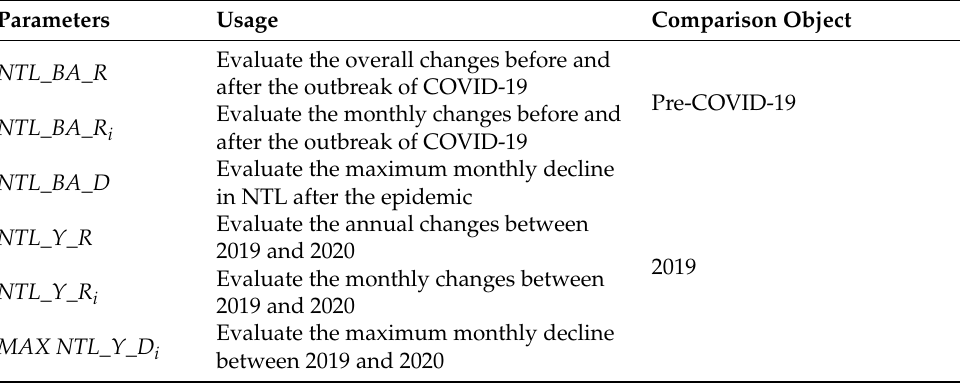
Table 1. Parameters and their